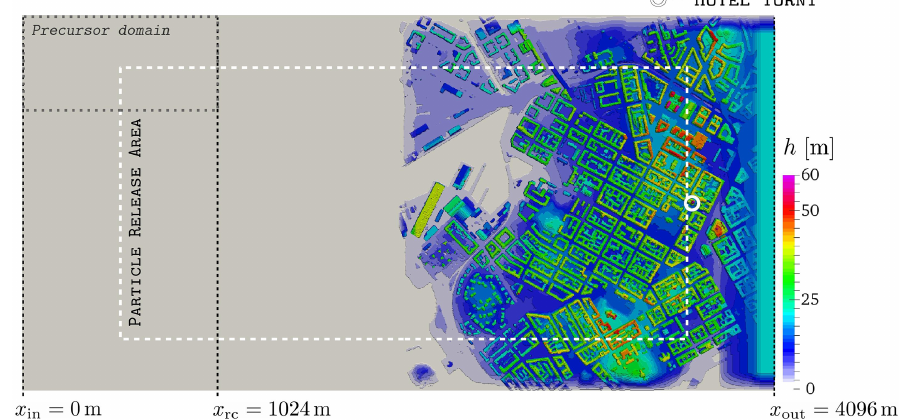
Figure 2. Visualization of the topography height distribution underlying the LES domain. The particle release area is enveloped by a white dashed line. The size of the precursor domain is outlined in the top left corner. The location of the turbulence recycling plane is marked by a black dotted line at x rc